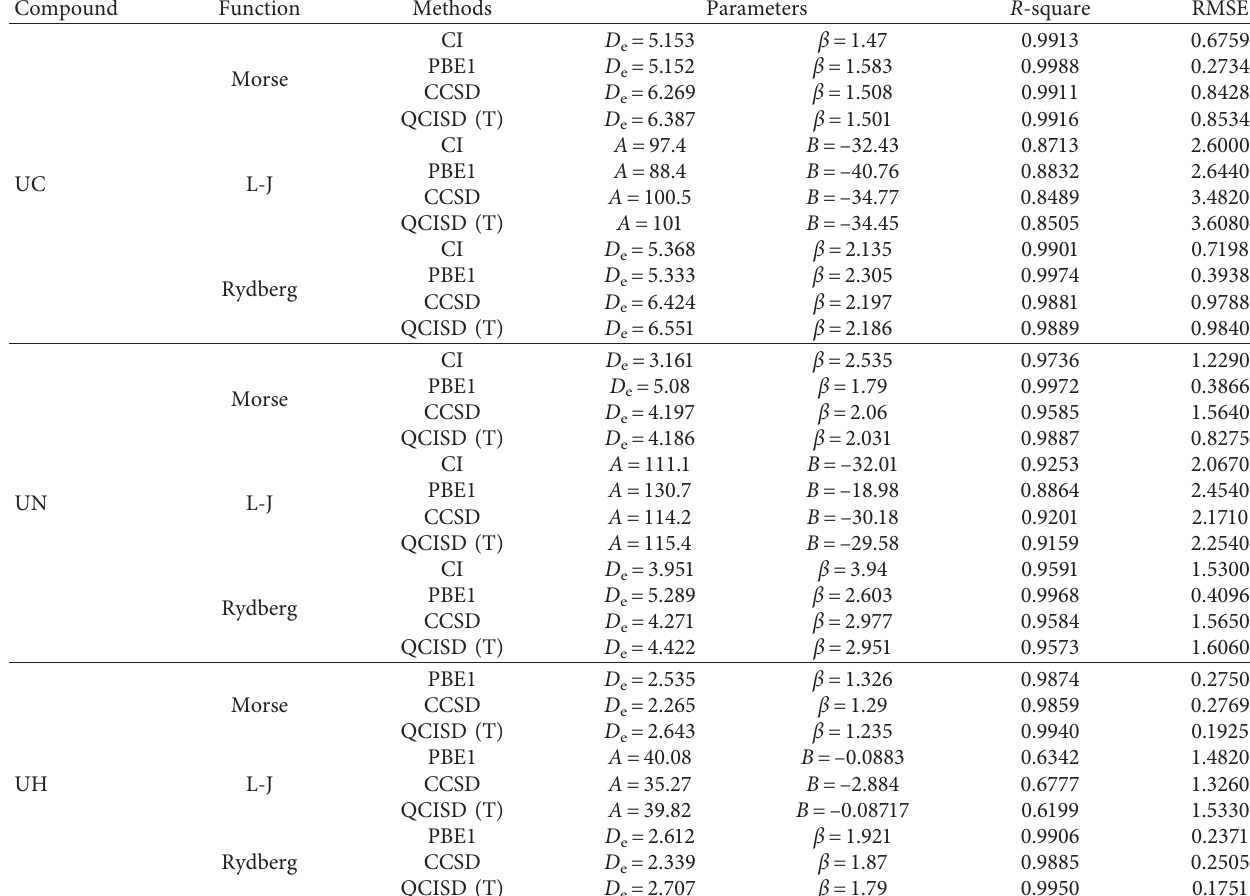
Table 1: Parameters of potential functions of UC, UN, and UH a .